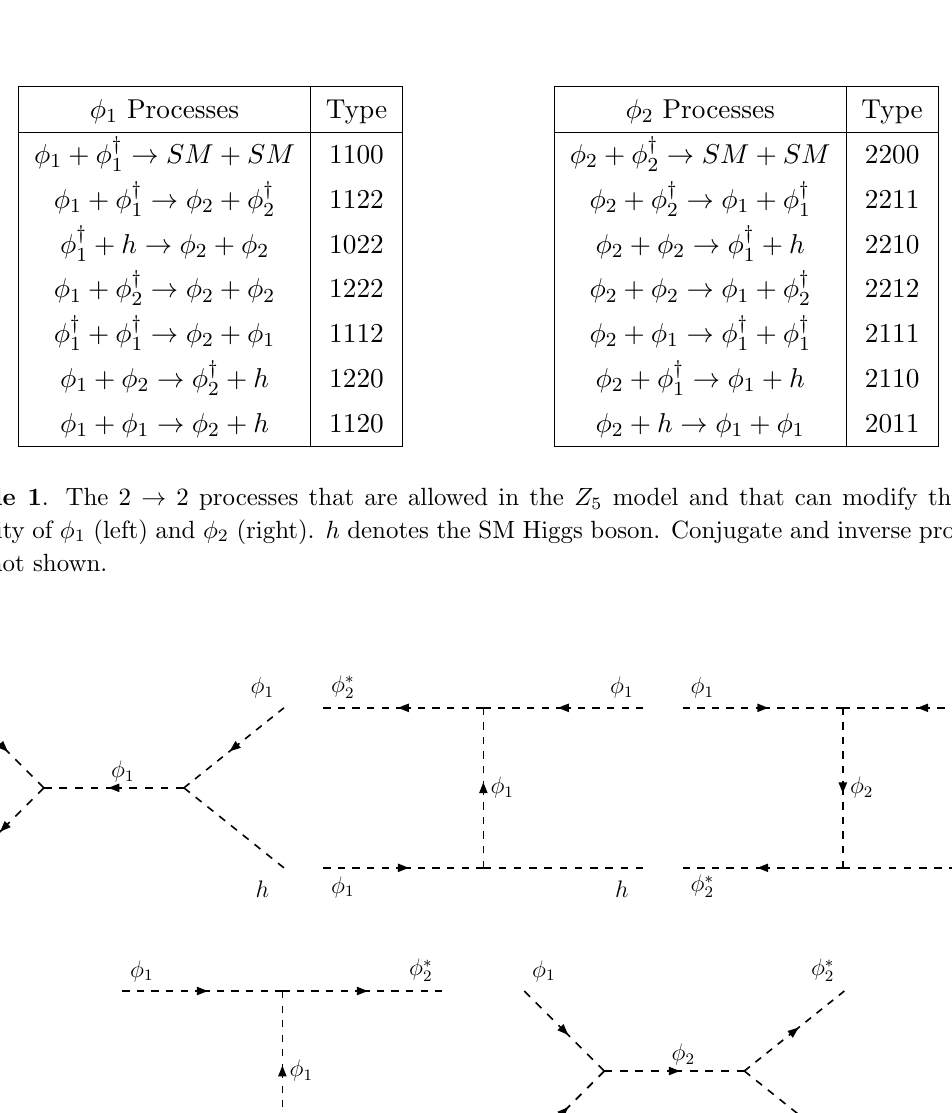
+ (cid:30) y ! (cid:30) + (cid:30) y , interference e(cid:11)ects are expected to play 2 1 2 1